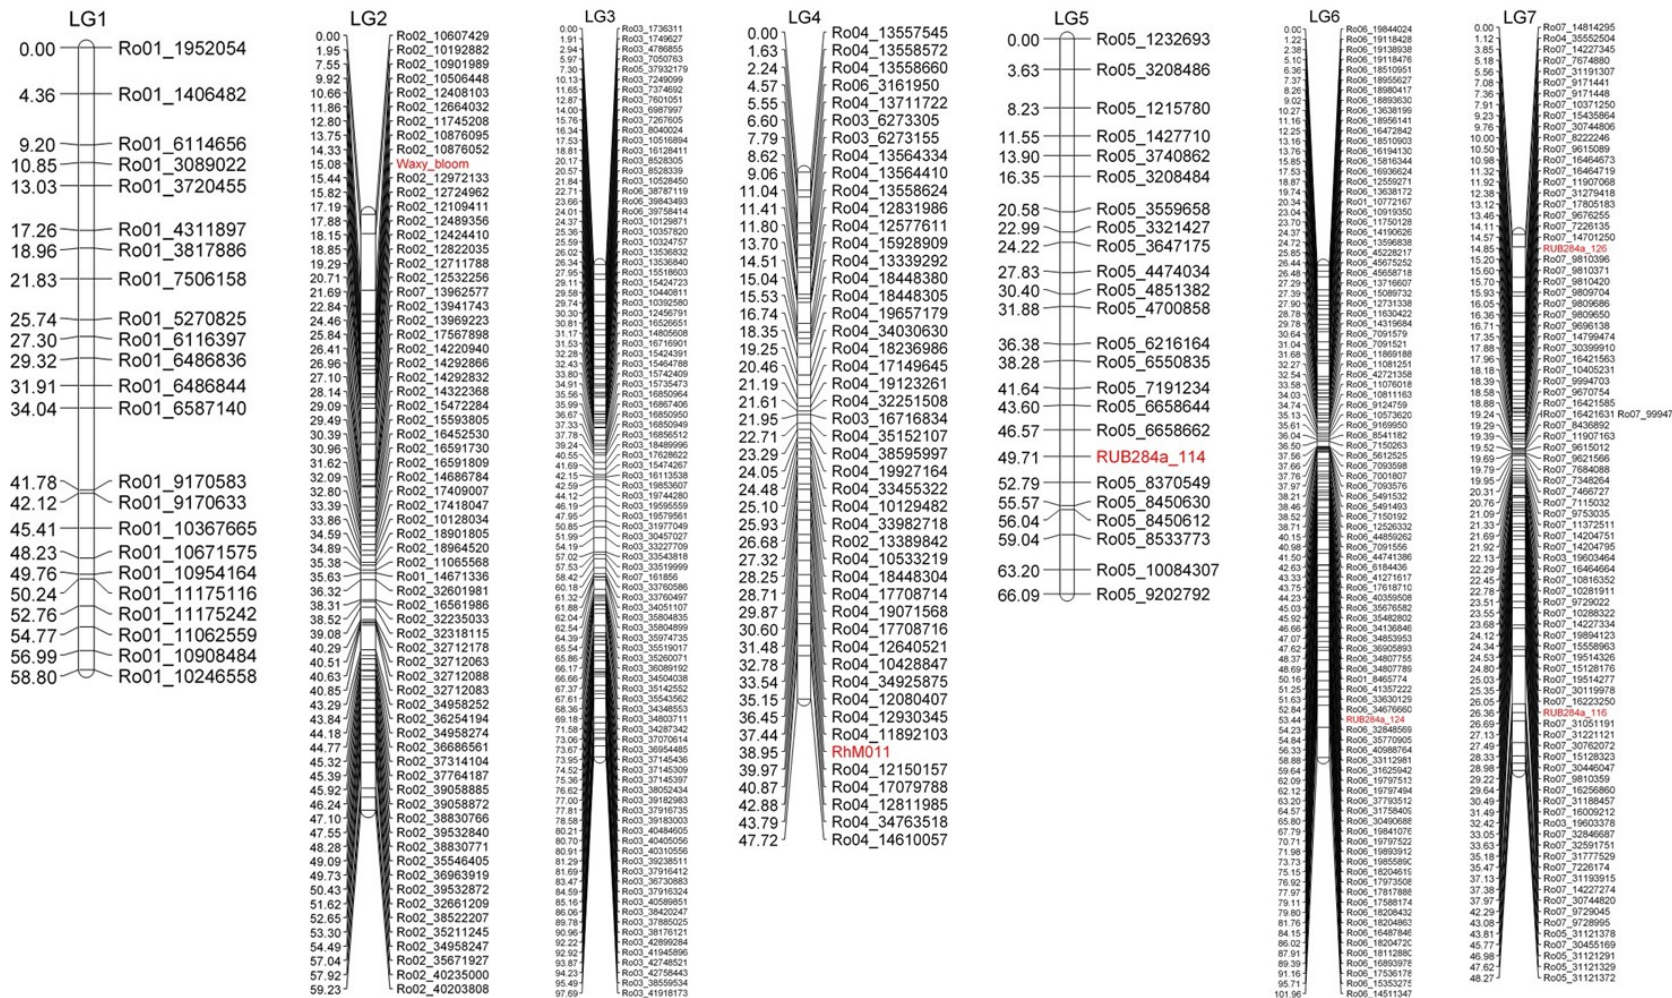
Figure 2. Genetic map of ‘Black Jewel’ showing seven linkage groups (LGs) that represent the seven chromosomes of Rubus . Waxy bloom maps on LG2 and is highlighted with the SSRs in red. Genetic distance is given in cM.